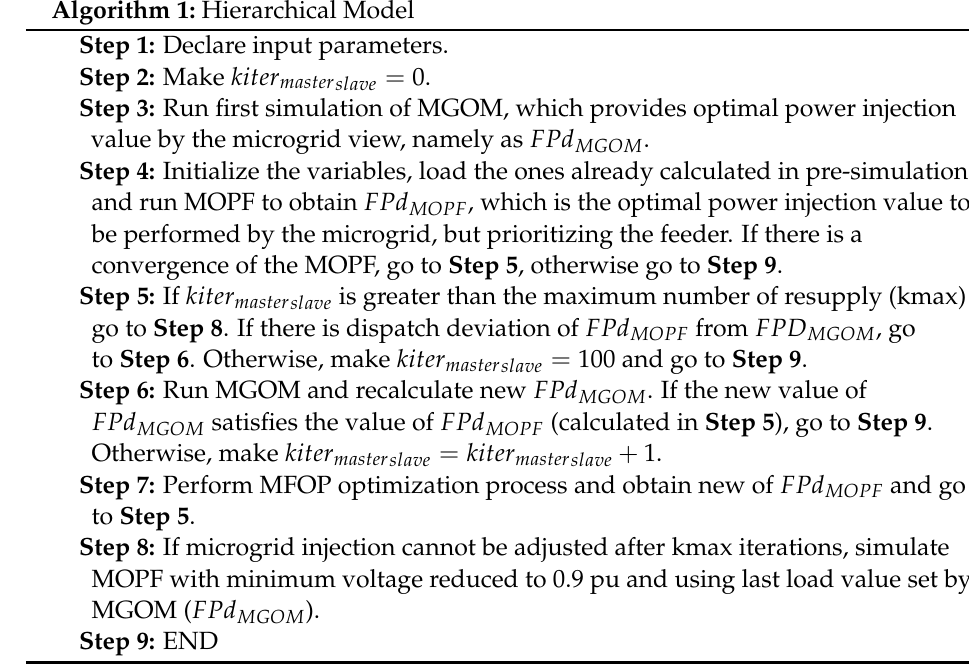
Algorithm 1: Hierarchical Model